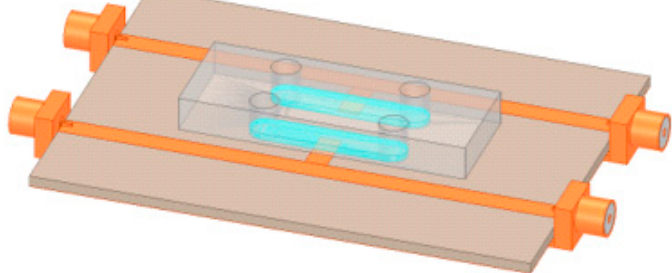
Figure 3. HFSS model of the uncoated microwave-based stub sensing device.